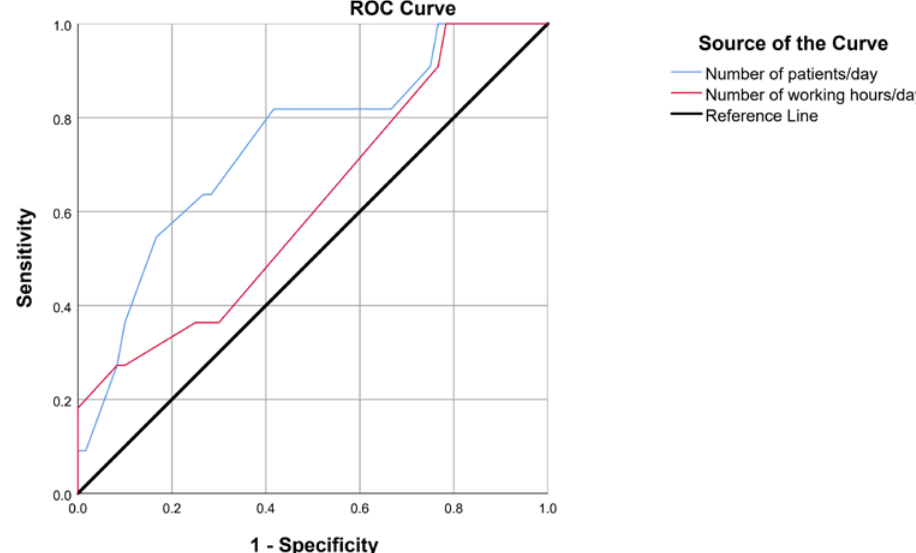
Figure 3. ROC curve for daily number of patients treated and daily working hours in predicting